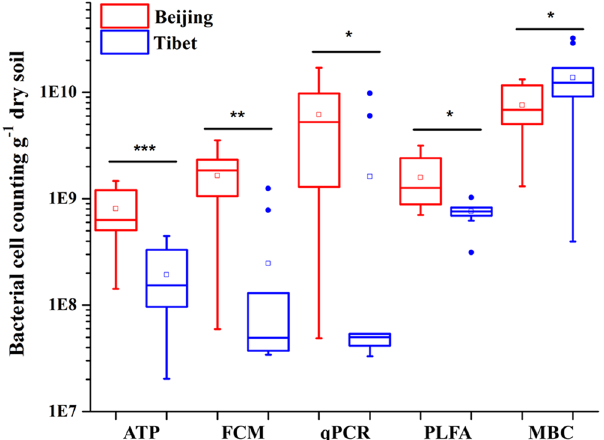
Figure 4. Comparison of the bacterial cell numbers between two sampling sites. ( * P < 0.05; ** P < 0.01; *** P < 0.001). Horizontal lines show median values, □ indicate mean values, boxes denote values comprised within the lower and upper quartile of the data, the vertical lines represent ranges, and • indicate outliers.